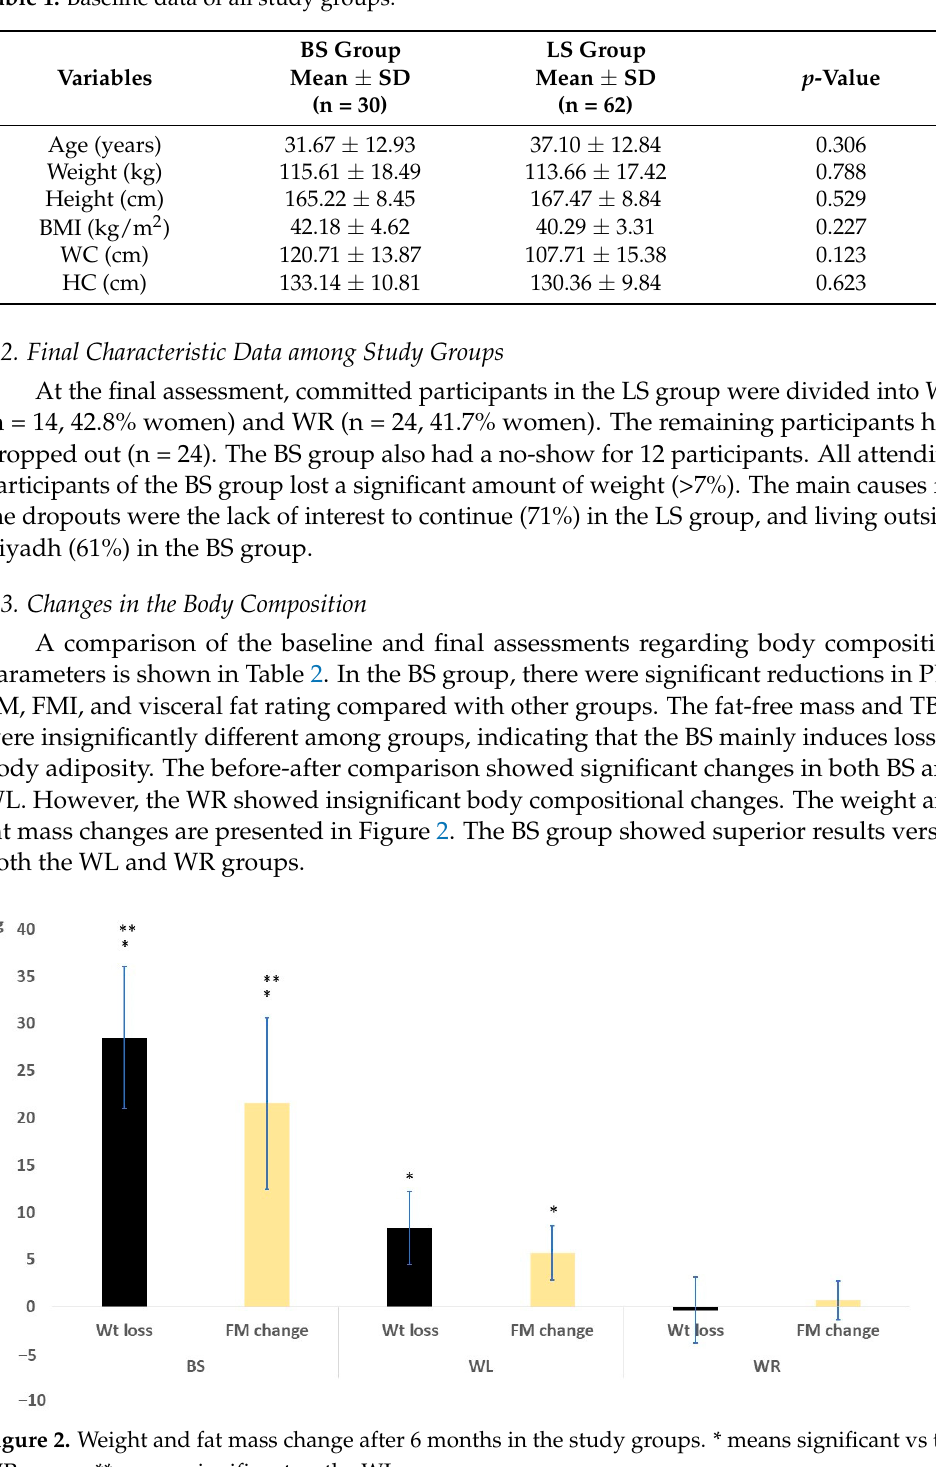
Table 1. Baseline data of all study groups.